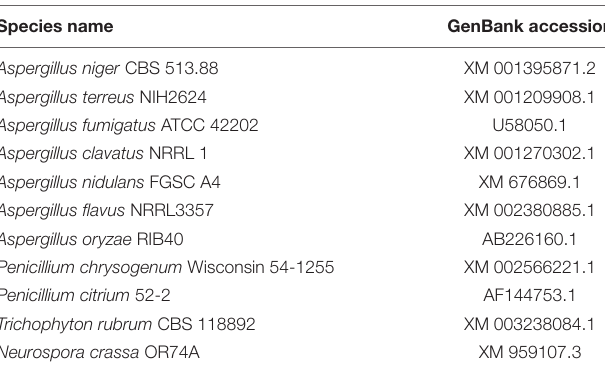
TABLE 1 | GenBank accession numbers of the sequences used in multiple alignment